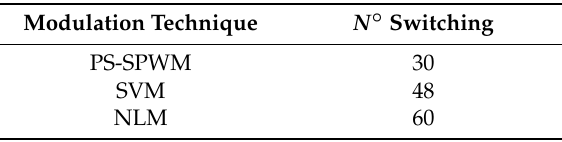
Table 1. Comparative of switching transitions per IGBT.